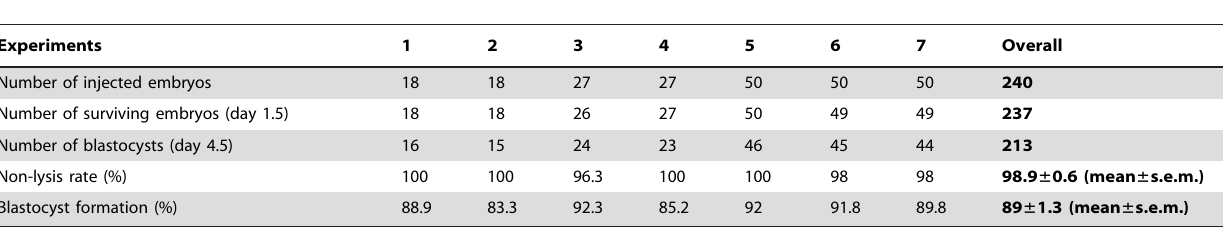
Table 1. Statistics of non-lysis and blastocyst formation rates of mouse embryos with PBS injection using the robotic system.